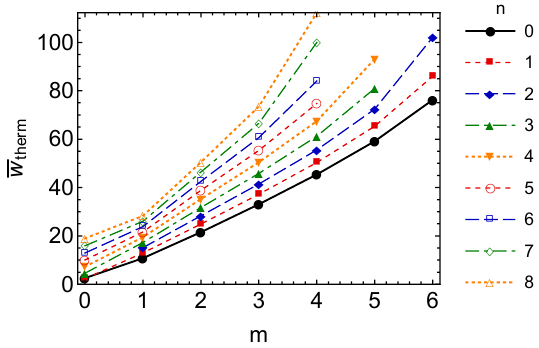
Figure 7 . Scaled thermalization time w therm as function of m . The di(cid:11)erent lines correspond to di(cid:11)erent values of n